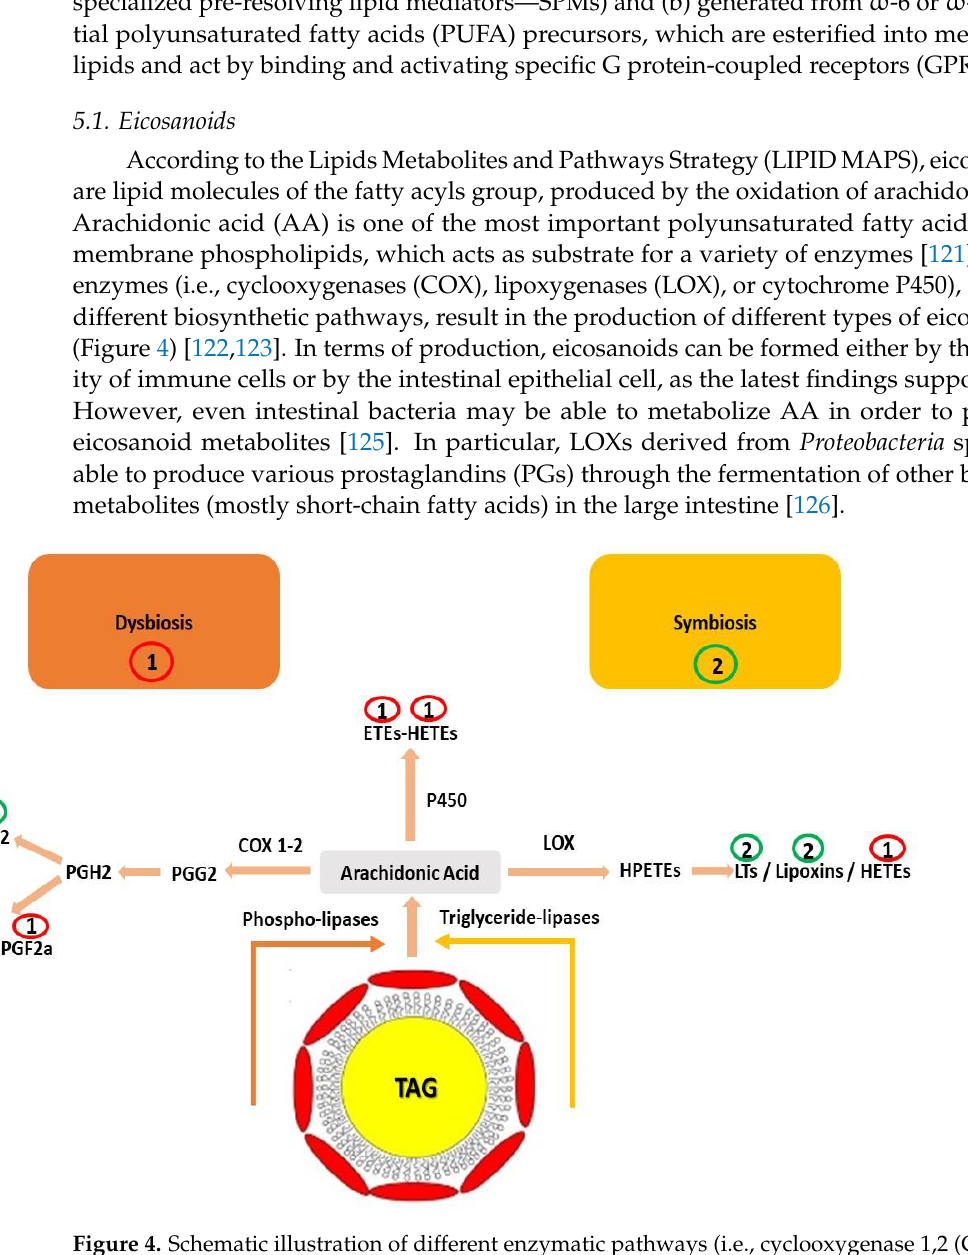
Figure 4. Schematic illustration of different enzymatic pathways (i.e., cyclooxygenase 1,2 (COX-1,2), lipoxygenase (LOX), and cytochrome 450 (CYP450)) of eicosanoids biosynthesis (i.e., prostaglandins (PGE, PGD, PGF, PGI, PGG), thromboxanes (TXs), leukotrienes (LTs), hydroxeicosatetraenoic acids (HETEs), and hydroperoxyeicosatetraenoic acids (HPETEs)) and their role in gut homeostasis [122]. Pink arrows indicate the different biosynthetic pathways, while red and green cycles are associated with gut dysbiosis or symbiosis, respectively.